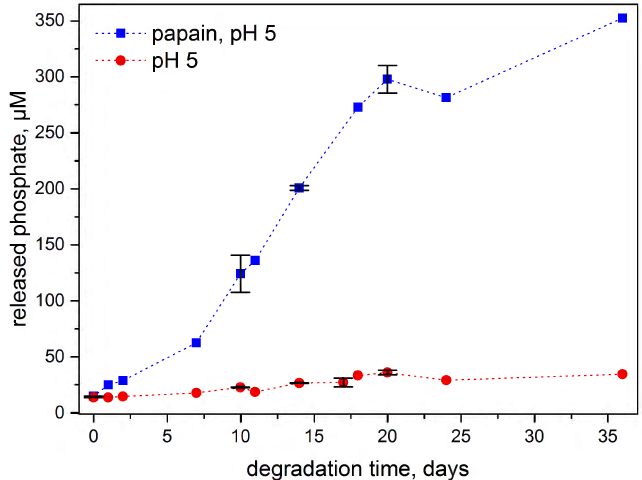
Figure 8. Phosphate determination of polymer 2 quantitatively determined by UV–Vis analysis to show the degradation profile of the polymer in aqueous conditions at pH 5 ( (cid:4) ) and with papain at